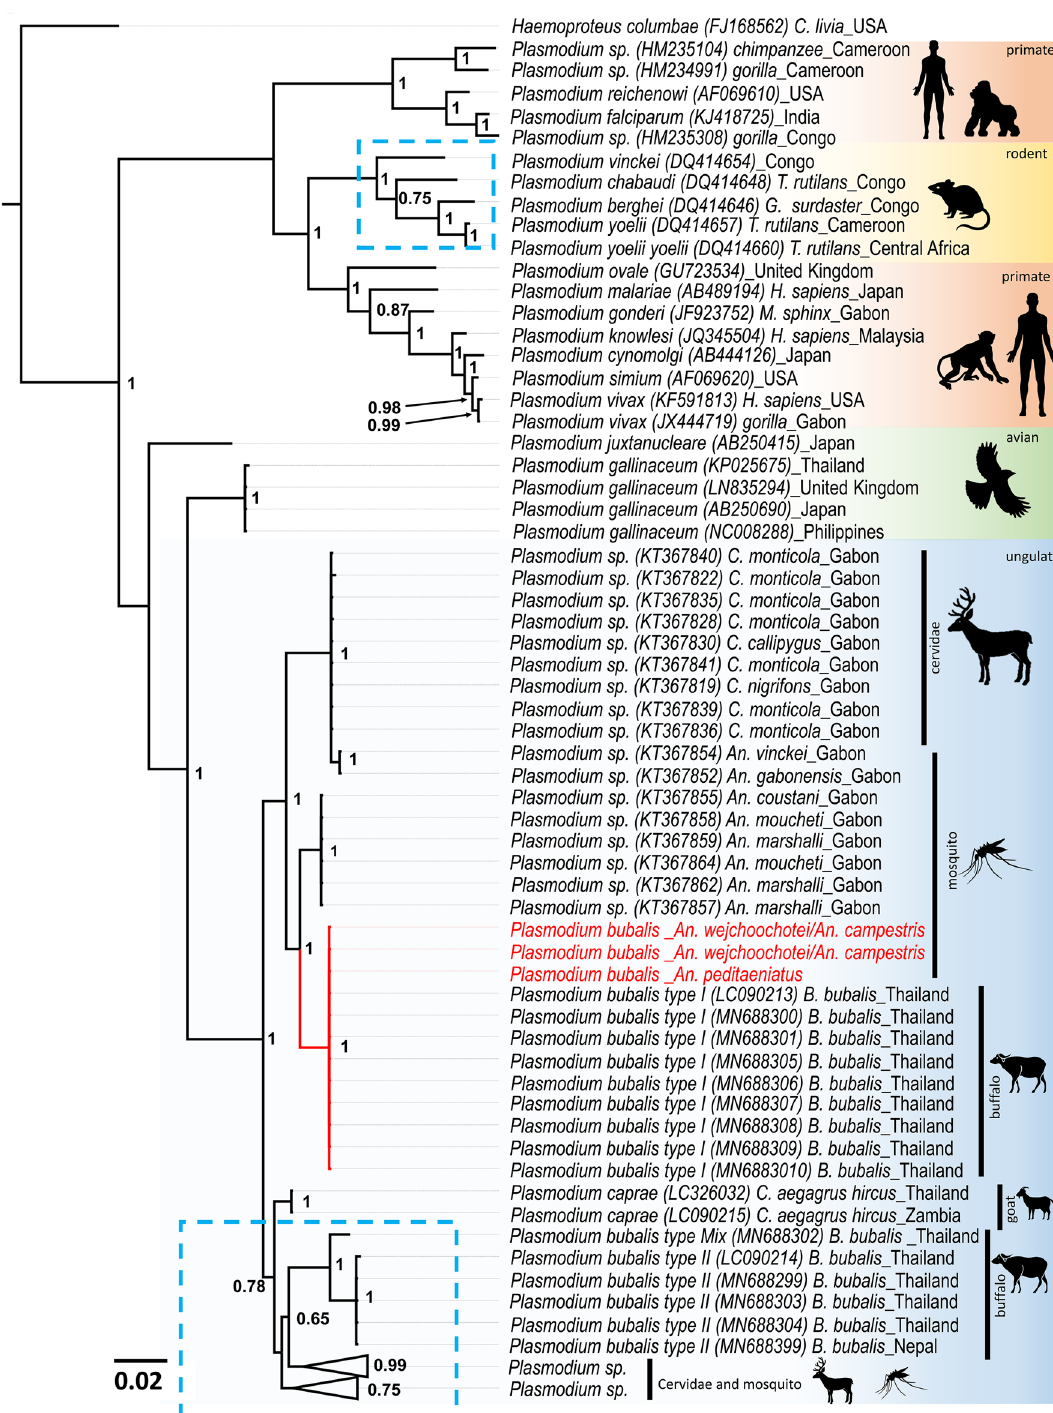
Figure 2. Phylogenetic positions of Plasmodium detected from Anopheles mosquitoes in this study. The phylogenetic tree was inferred by Bayesian inference method using partial cytb sequences (789 bp). Haemoproteus columbae was used to root all sequences. At the nodes, Bayesian posterior probabilities (PP ≥ 0.65) are indicated. Plasmodium sequences obtained in this study are highlighted in red. The length for the substitutions/site (0.02) is